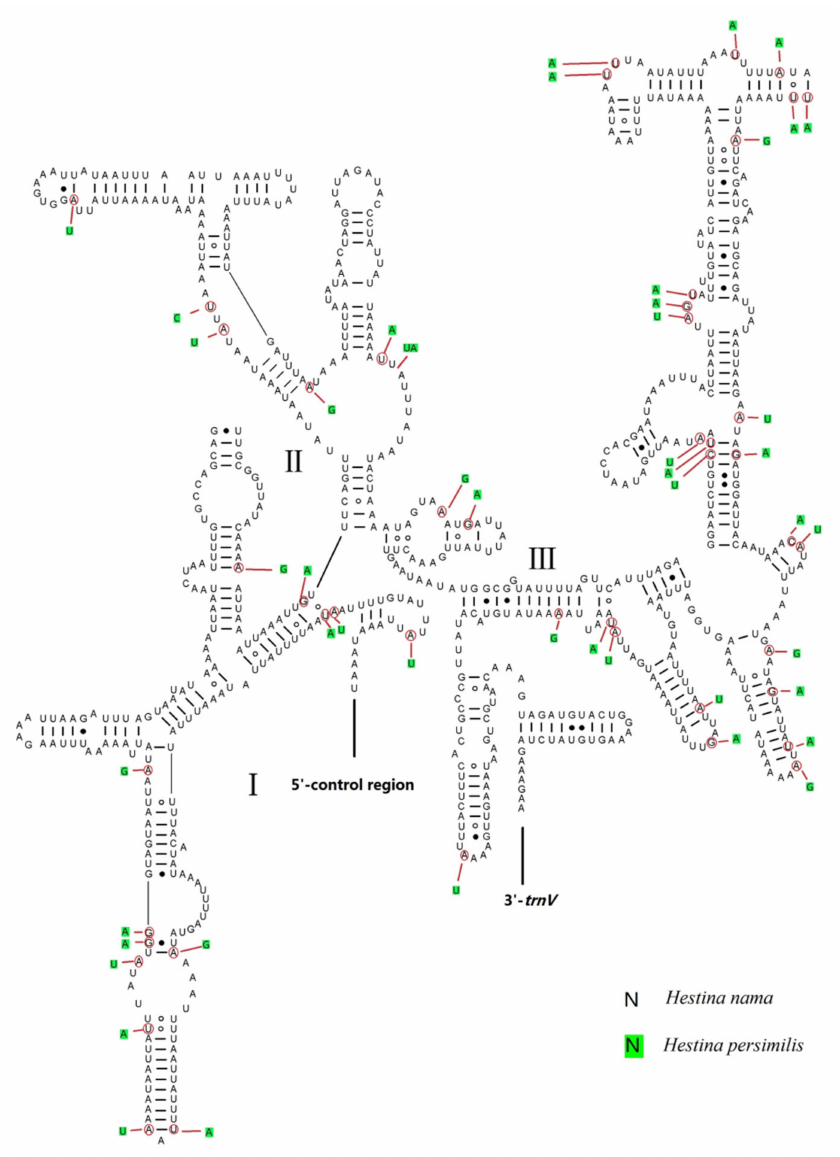
Figure 7. Predicted rrnS secondary structure of Hestina persimilis and Hestinalis nama mitogenomes. Dashes, black dots and circles indicate the Watson–Crick base pairings, G-U bonds and U-U, A-A, A-C, A-G bonds,